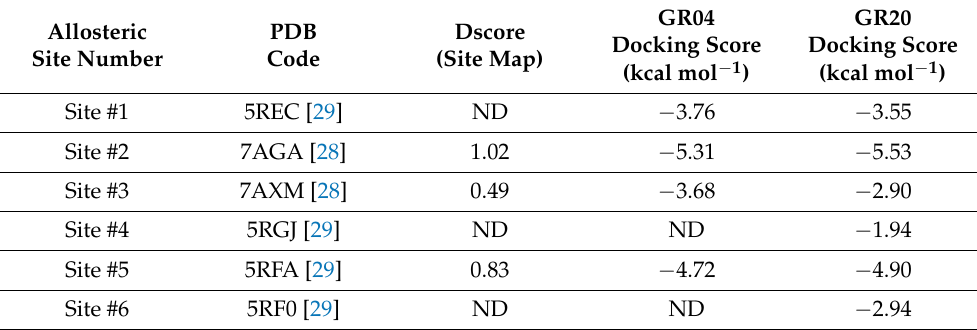
Table 4. The Dscore values of the putative M pro allosteric sites along with the docking scores of GR04 obtained for each of the tested pockets (ND: not